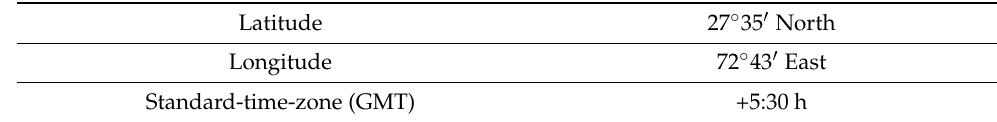
Table 1. Reference site coordinates and Standard ‐ Time ‐ Zone.